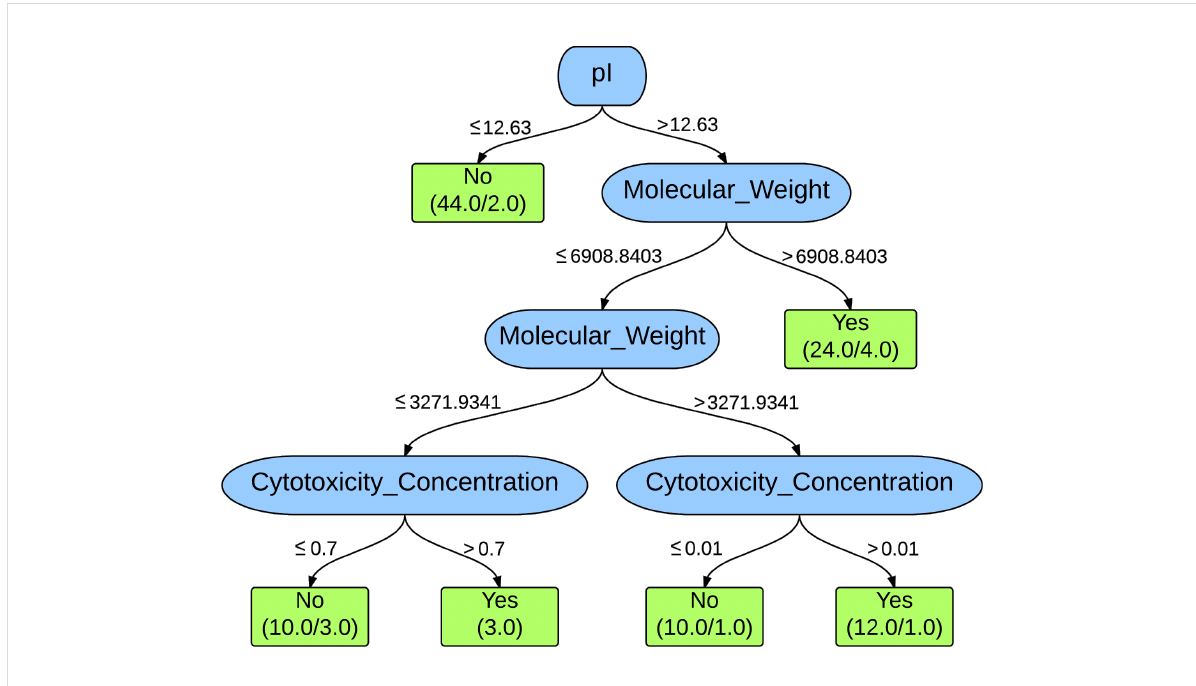
Figure 2: Decision tree for 10-fold cross-validation J48 classifier for the fourth analysis including the molecular descriptors expert-selected with the concentration information of dendrimers used in the experiments. The values present on the branches represent the rule or decision used for making the classification. The boxes at the bottom represent the classifications with the number of PAMAM dendrimers classified as such on the left and the number of exceptions (misclassifications) on the